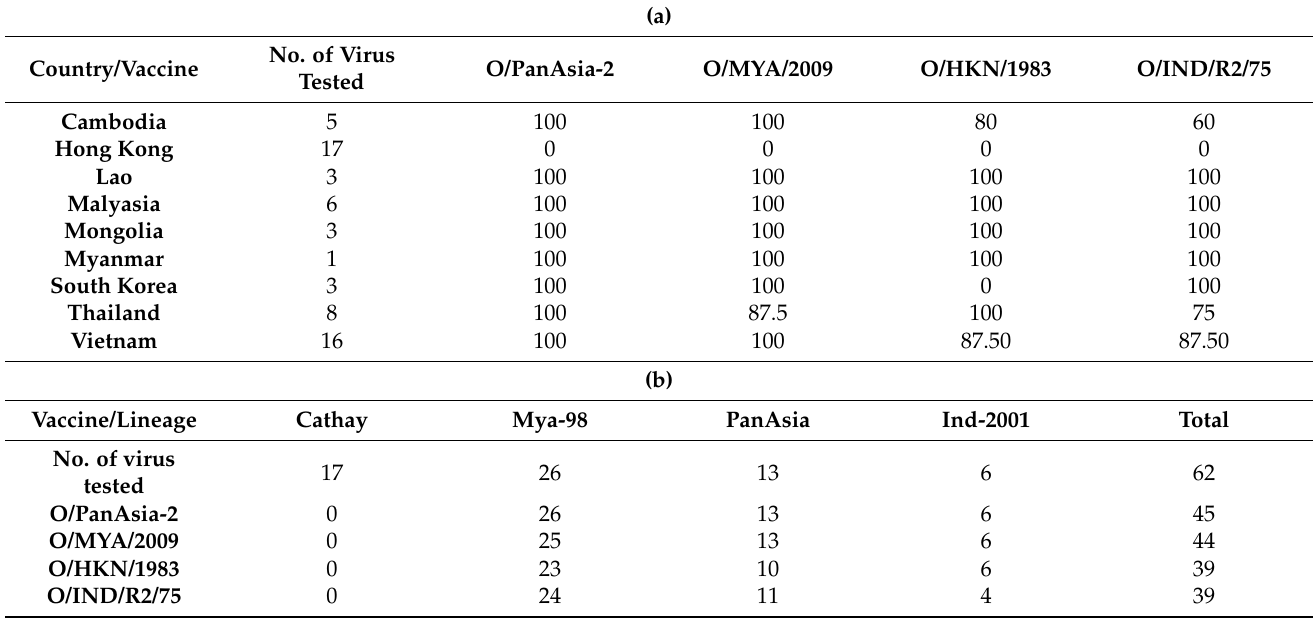
Table 2. ( a ) List of SEA and EA countries showing % in vitro protection by each vaccine strain. ( b ). List showing the number of FMDV isolates from each lineage with positive cross-reactivity (r 1 -values ≥ 0.3) with bovine post-vaccinal sera (BVS). (a)